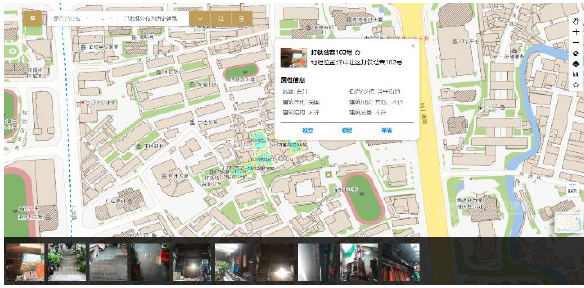
Figure 4. Inquiring the basic information and photos of a historic building